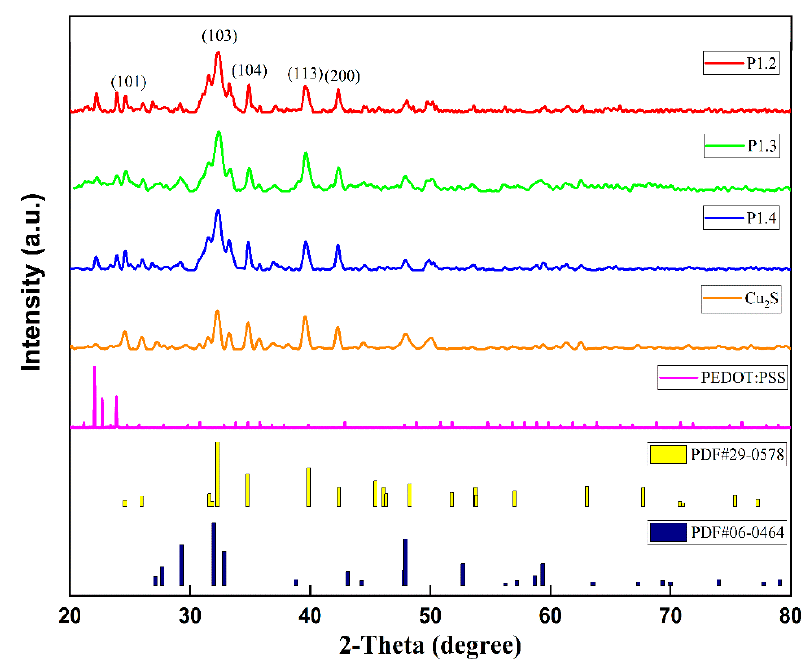
Figure 2. XRD patterns of powder and films.